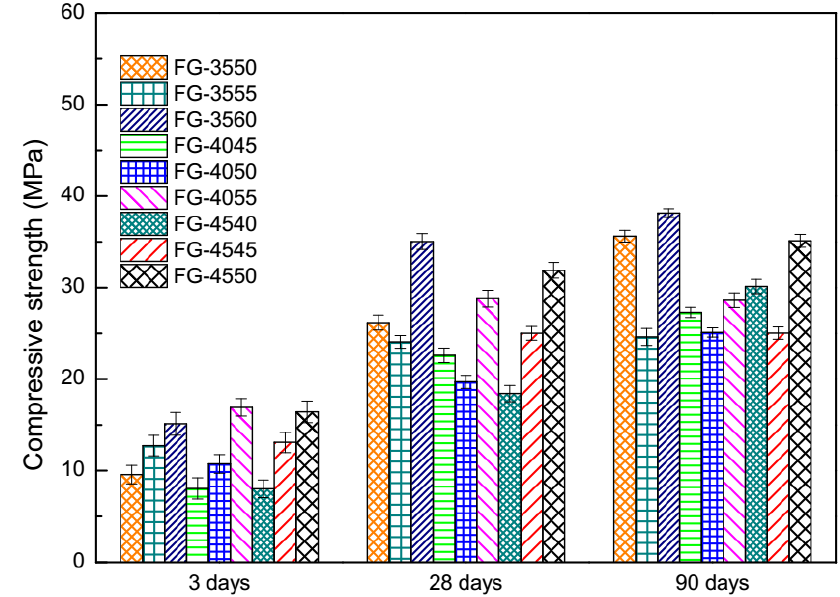
Figure 2. Compressive strength of FGD gypsum-based mortars with S95-GGBS under normal curing conditions.